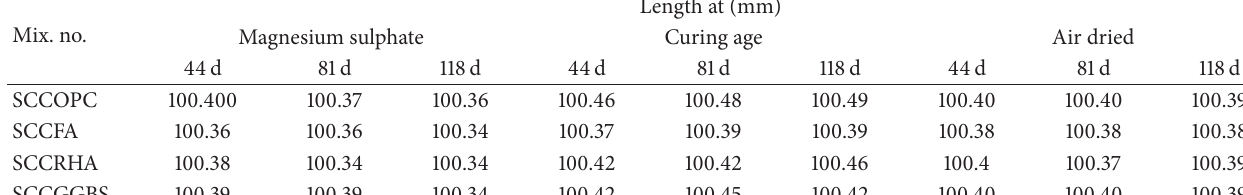
Table 8: Length affected by the addition of MS and curing ages at SCC.